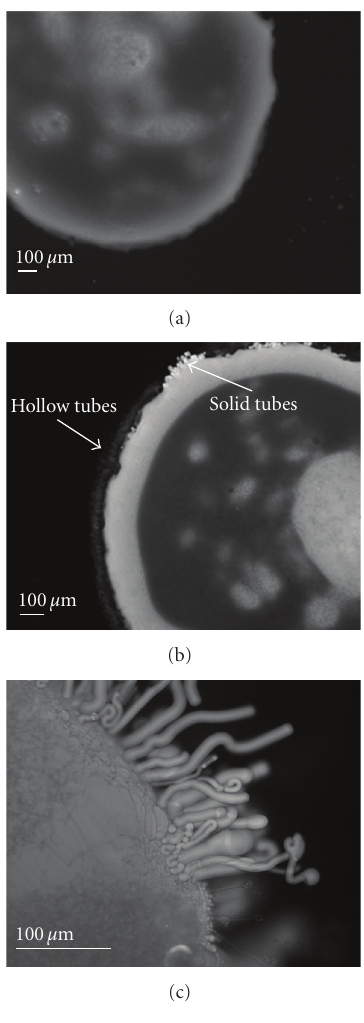
Figure 1: Fluorescent images of (a) dry lipid plaque (b) after myelin figure formation upon hydration. As can be seen di ff erent groups of myelin figures are protruding from distinct regions (c) higher magnification of solid